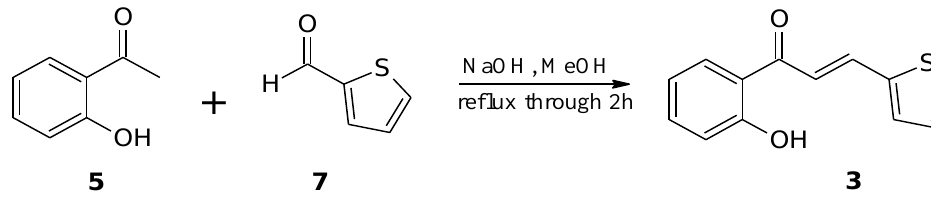
Figure 5. Synthesis of 3-( 2” -thienyl)-1- (2’ -hydroxyphenyl)-prop-2-en-1-one ( 3 ).